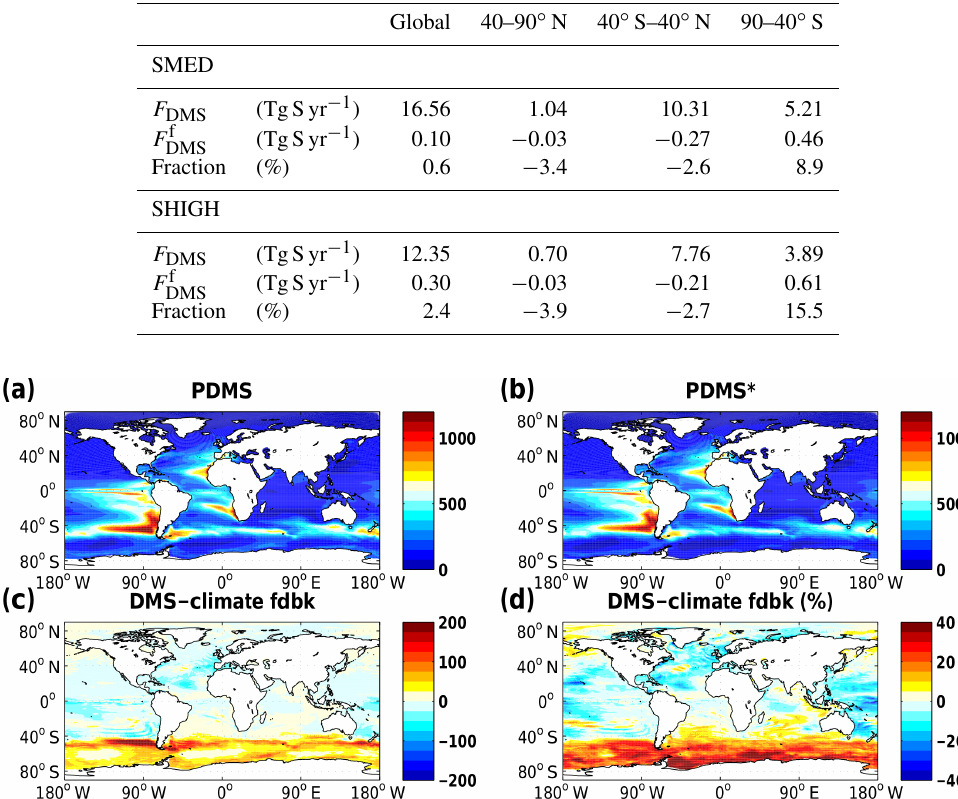
Figure 9. Averages over 2171 to 2200 of (a) DMS production for the experiment SHIGH, (b) an estimate of the DMS production that would occur in SHIGH without DMS–climate feedback ( P ∗ absolute values, and (d) the DMS–climate feedback expressed in percent of the total DMS production shown in panel (a) . Units in (a) – (c) are mgSm − 2 yr − 1